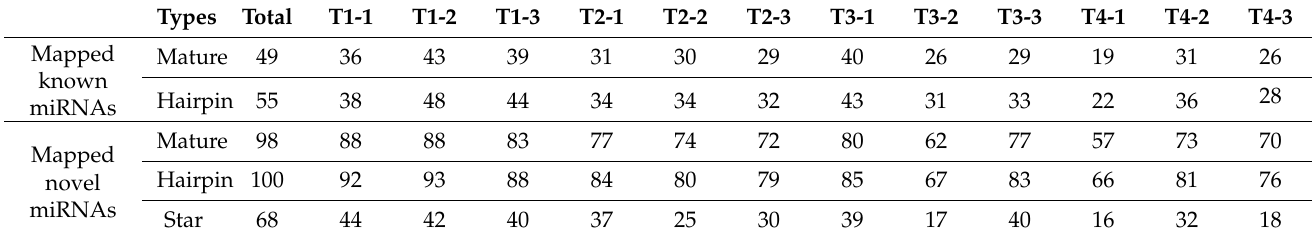
Table 2. Quantity of the known miRNAs and predicted novel miRNAs in T. hybrid